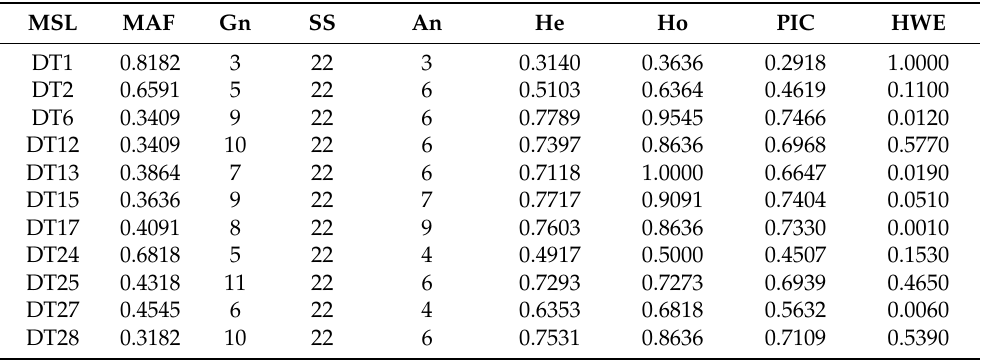
Table 4. Characteristics of the 13 polymorphic microsatellite loci in the Dorcus titanus castanicolor specimens from Daejeon,